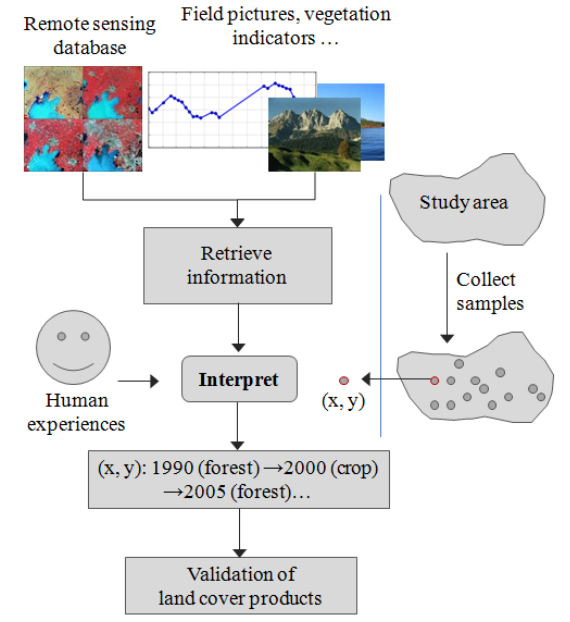
Figure 2. Interpreting land cover types at samples collected in a given area